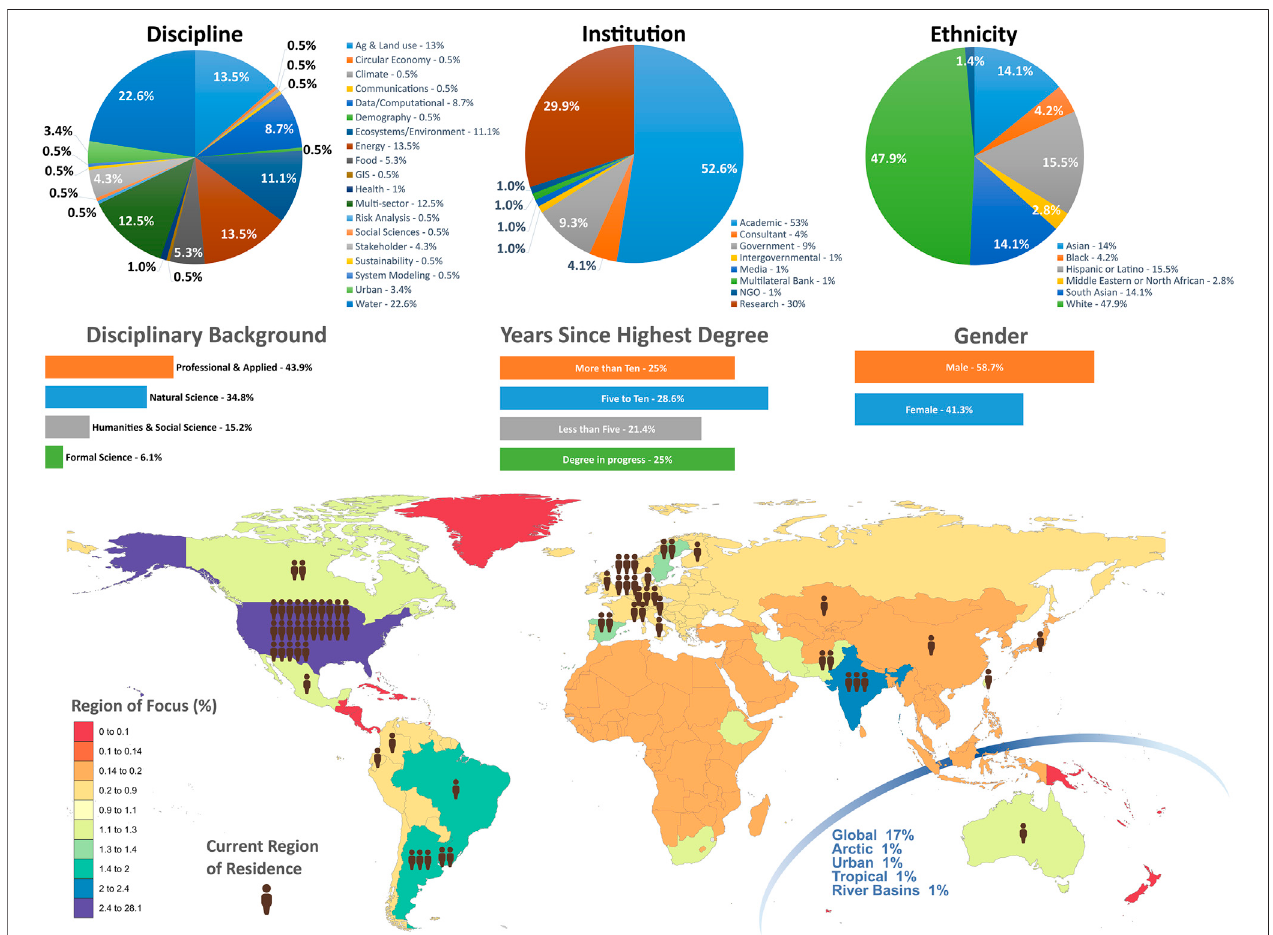
FIGURE 1 | Results of the author diversity surveys on disciplinary background, institution type, career-stage, ethnicity, gender and geographical area of residence and focus. Respondents could select more than one choice for these questions, as well as provide their own custom answers if desired. Note that disciplinary backgrounds in the survey were de fi ned as: Professional & Applied (Engineering, Law, Business, Medicine, Journalism etc.); Natural Science (Physics, Chemistry, Biology, Earth Sciences, Space etc.); Humanities & Social Science (Anthropology, Sociology, Psychology etc.); and Formal Science (Math, Logic, Computer Science